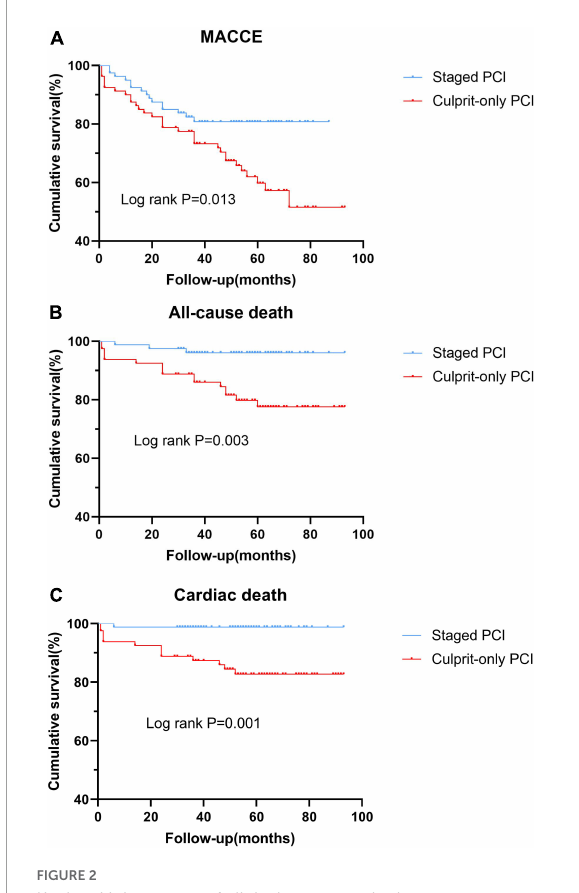
FIGURE2 Kaplan-Meier curves of clinical outcomes in the two groups after the propensity score matching analysis. (A) MACCE; (B) all-cause death; and (C) cardiac death. MACCE, major adverse cardiac and cerebrovascular event; PCI, percutaneous coronary intervention.